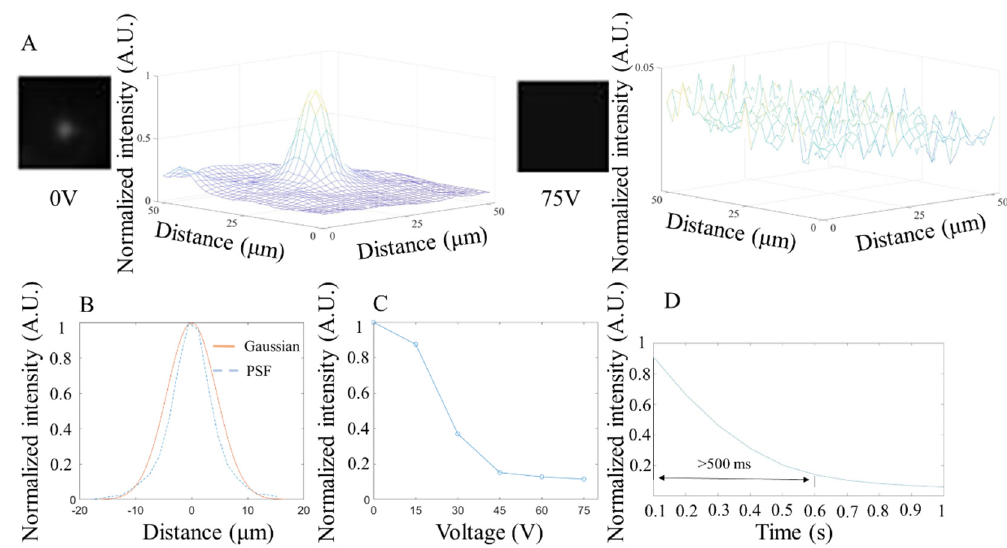
Figure 8. Characterization of NLC at 680 nm wavelength. ( A ). The microscope image of the NLC and the light intensity distribution color map at 0 V ( left ) and 75 V ( right ). ( B ). The NLC’s point spread function and Gaussian fitting curve at 0 V. ( C ). Average measurement of light intensity changes under different voltages. ( D ). Average response time (change from 90% to 10% of the normalized light intensity step height) of the NLC under 75 V (n = 5).